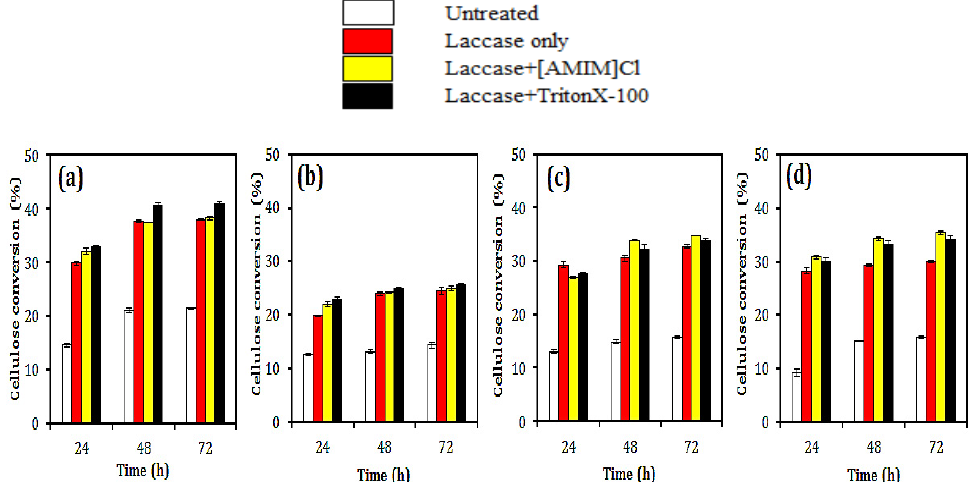
Figure 2. Profiles of enzymatic hydrolysis from rice straw (RS) pretreated by laccase with [AMIM]Cl or TritonX-100 and hydrolyzed with cellulase complex (50 FPU/g RS) and β -glucosidase (40 CBU/g RS) by four enzymatic saccharification strategies, ( a – d ), which were described in the Materials and Methods.